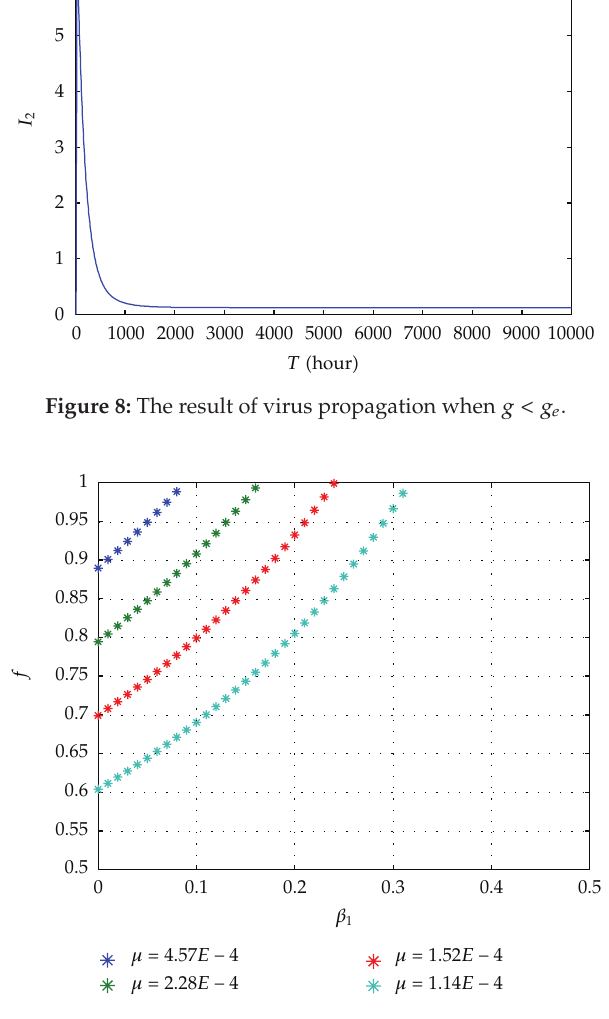
Figure 9: The e ff ect of di ff erent μ on f e